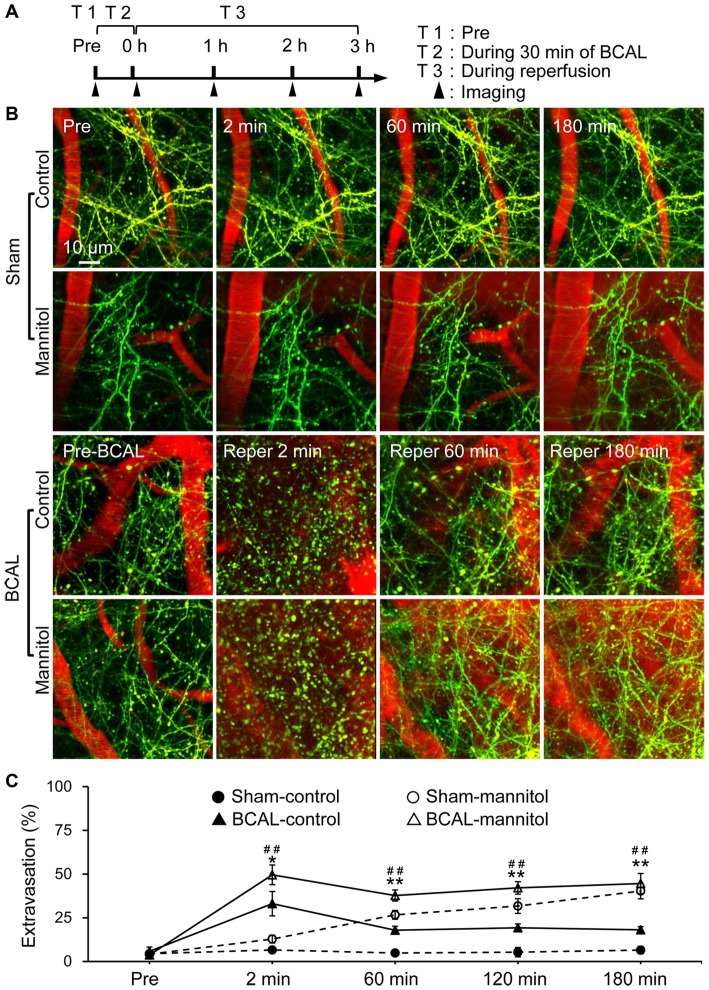
Mannitol-induced change in blood-brain barrier (BBB) permeability after transient global cerebral ischemia. (A) Timeline shows time points for imaging during the transient ischemia-reperfusion model. Filled arrowheads show the imaging time points. (B) Two-photon images show Evans blue (EB) labeled extravasation (red) and dendritic structures (green) at pre, 2 min, 60 min and 180 min, respectively in sham-control mice, sham-mannitol mice, bilateral common carotid artery ligation (BCAL)-control mice and BCAL-mannitol mice. Note that beaded dendrites induced by transient ischemia restored following reperfusion in both BCAL-control mice and BCAL-mannitol mice. (C) Group data shows relative changes of extravasation at different time points (n = 6 mice per group. Sham-control vs. Sham-mannitol (*) *p < 0.05 and **p < 0.01; BCAL-control vs. BCAL-mannitol (#) ##p < 0.01).